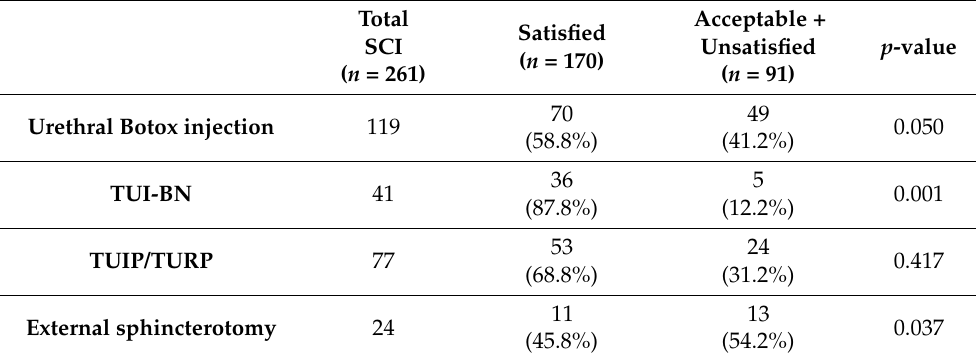
Table 4. Overall satisfaction with final bladder management and urological surgeries for spontaneous voiding.